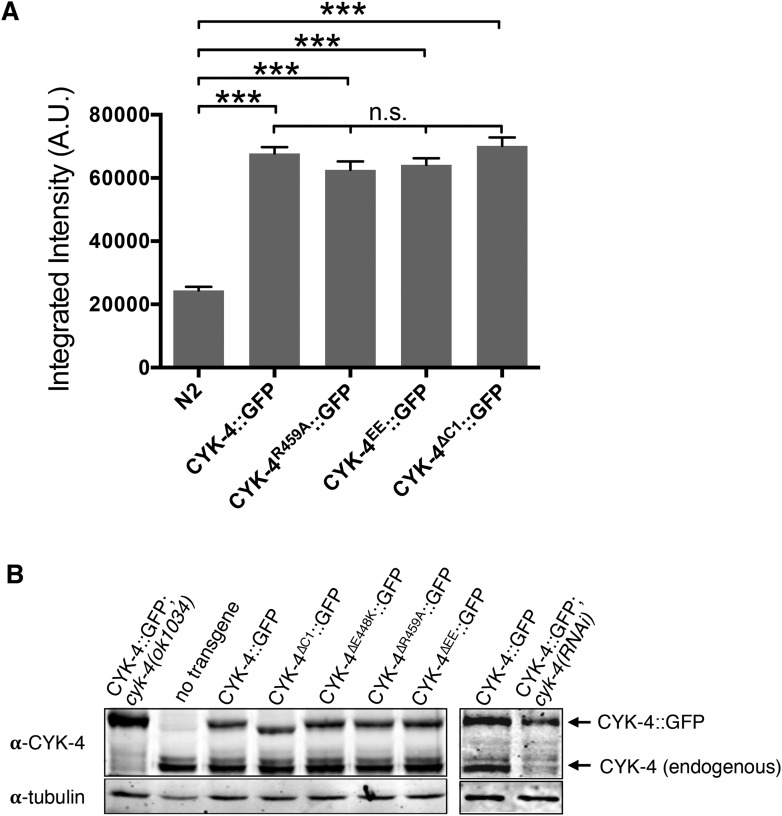
Transgene expression levels.(A) Quantification of the expression of CYK-4::GFP transgenes in embryos. Embryos were assayed in the first cell division and the total fluorescence intensity was measured. (N ≥ 8 embryos; error bars, s.e.m; ***p < 0.001; n.s., not significant, by one way ANOVA followed by Tukey multiple comparison). (B) Quantification of the expression of CYK-4::GFP transgenes. Total worm lysates were prepared from adult worms, standardized for total protein concentration and blotted with an anti-CYK-4 antibody. In the case of the RNAi experiment, 120 gravid adults worms were treated with cyk-4(RNAi) or control treated and subjected to western blotting.